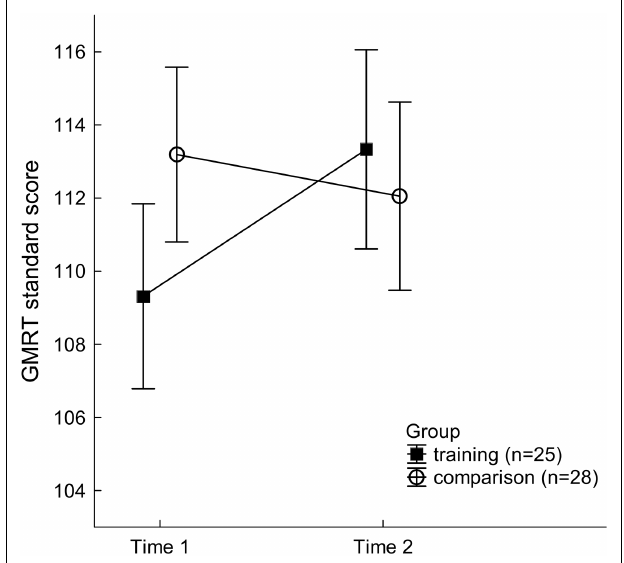
FIGURE 1 | Gates MacGinitie ReadingTest (GMRT) standard scores for the two participant groups atTime 1 andTime 2. Mean values of 25 training group students (filled squares) and 28 comparison students (open circles) are depicted.Vertical bars represent standard errors of mean.While there was no significant change in reading performance in the comparison group, GMRT scores in the training group increased significantly fromTime 1 toTime